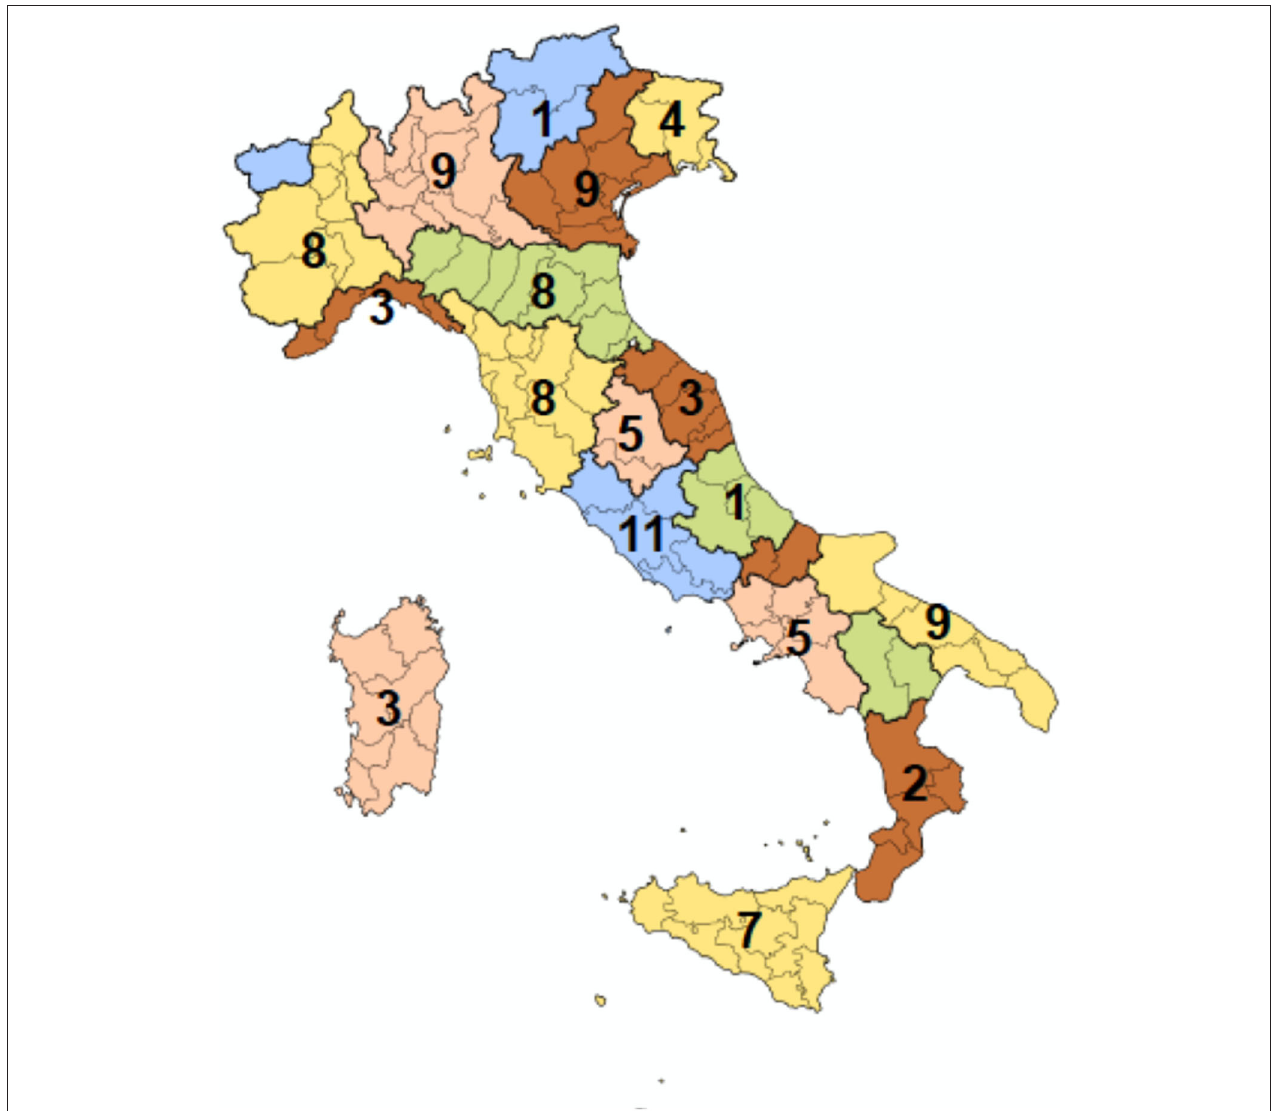
FIGURE 1 | Geographical distribution by region of centers included in the survey ( n =